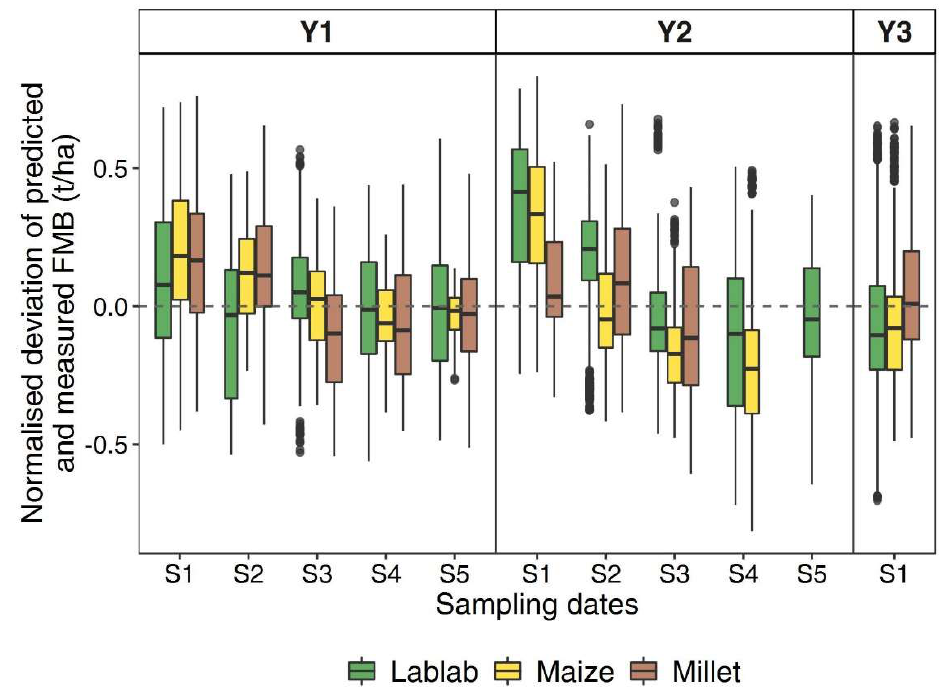
Figure 8. Normalised deviation between predicted and measured fresh matter biomass (FMB) for lablab, maize and finger millet at each sampling date (S1–S5) over three years (Y1–Y3). Predictions were based on the Generalised model. Values were averaged over 11 sampling dates (2016–2018) and two levels of water supply (i.e., rainfed and irrigated).